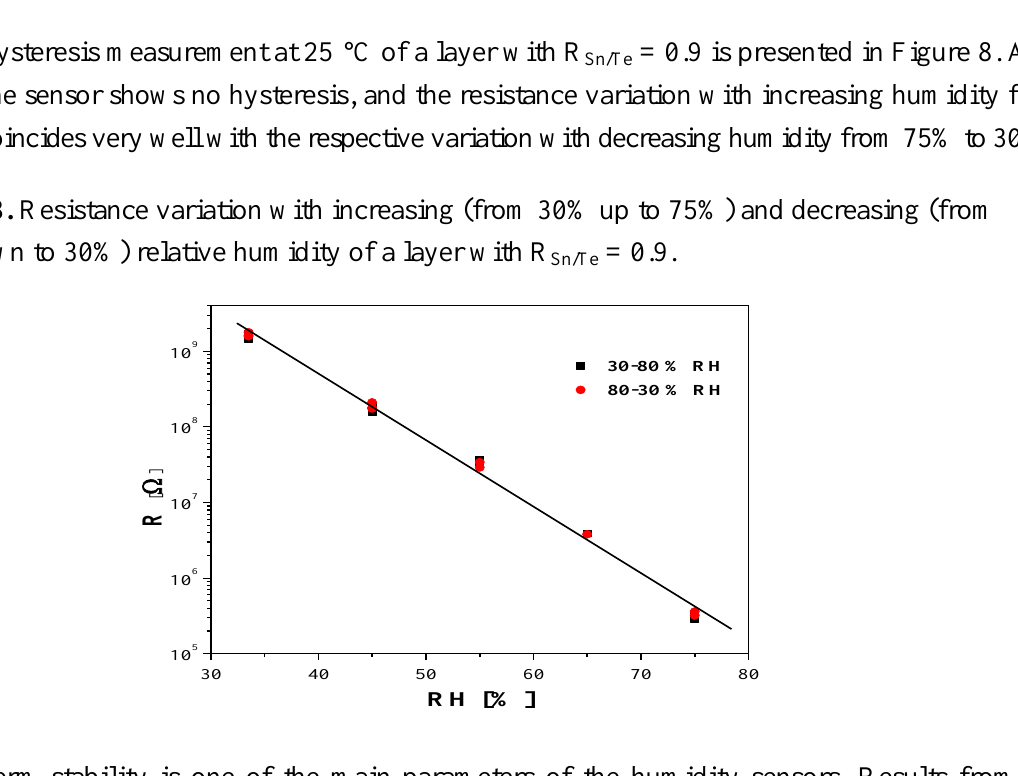
Figure 9. Long-term stability of Sn-O-Te humidity sensors with R